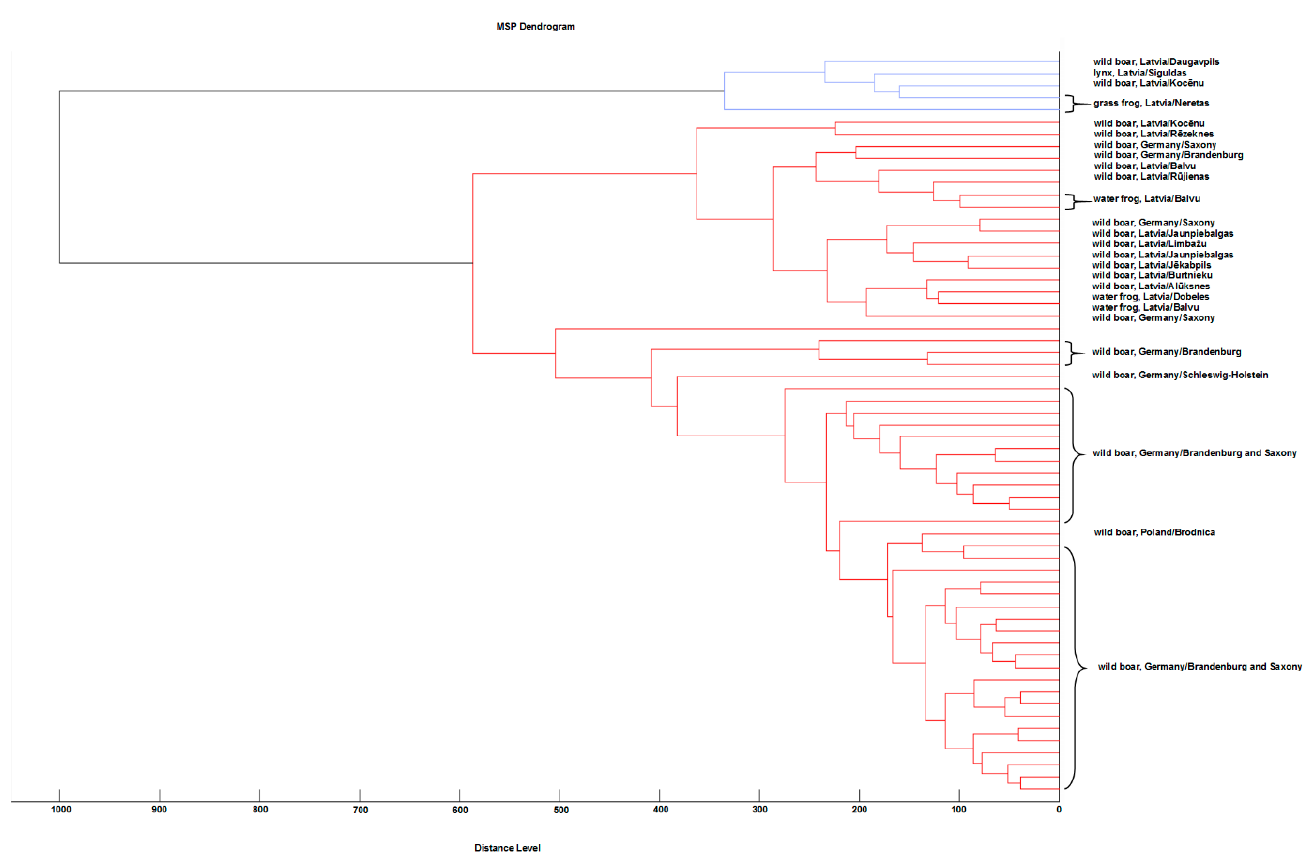
Figure 1. Heat map of 61 A. alata main spectra profiles (MSP) based on log scores. Each MSP represents one host individual. The presented figure is sorted by host species, country and region of origin. Nos 1 to 54 are wild boars, nos 55 and 56 are common frogs, nos 57 to 60 are water frogs and no. 61 is a lynx. Further information about the A. alata samples are listed in Table 1.